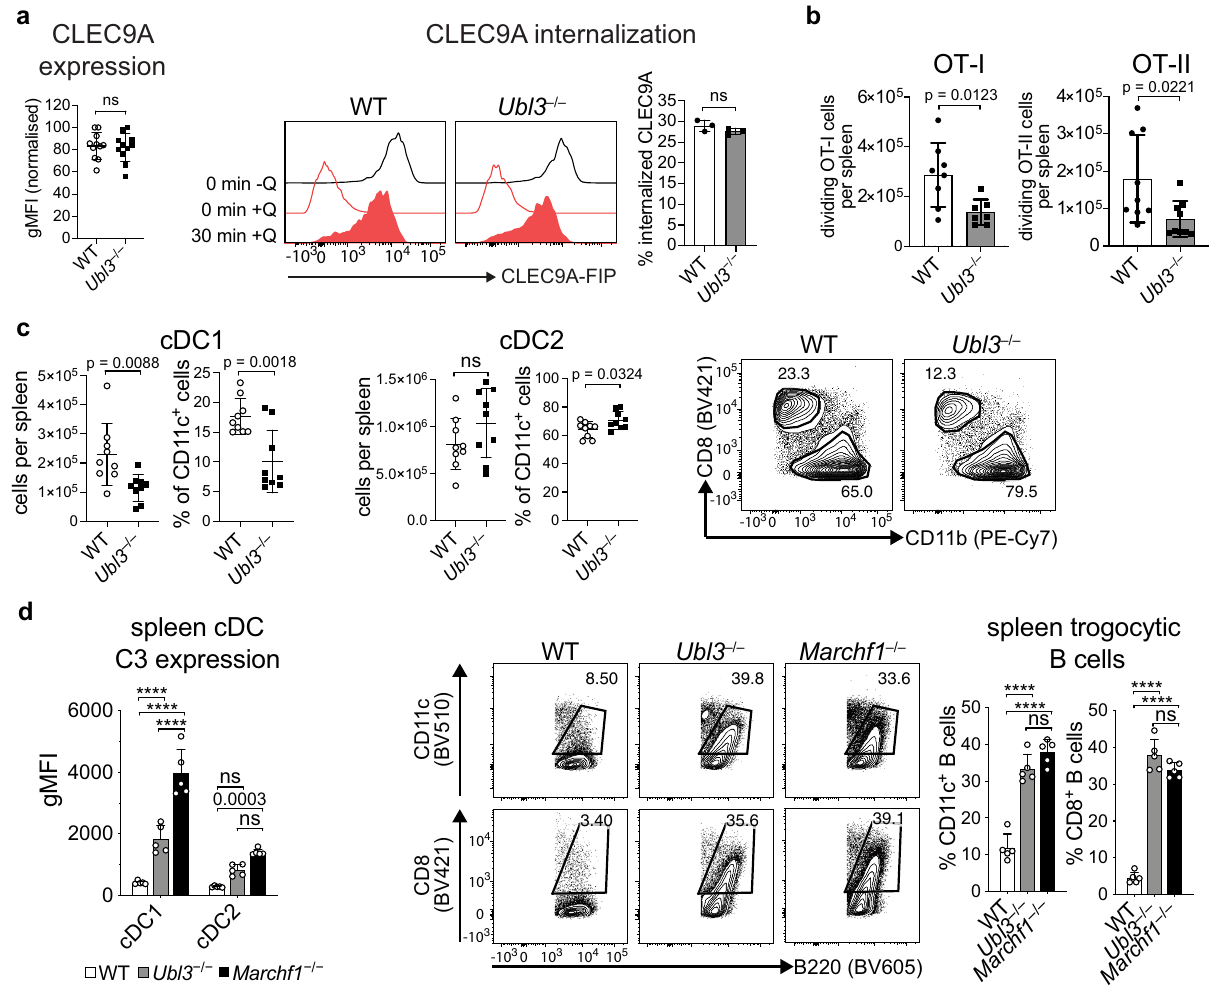
Fig. 6 Lack of UBL3 impairs DC-targeted antigen presentation in vivo. a Left: spleen cDC1 expression of CLEC9A from wild type (WT) or Ubl3 − / − mice by fl ow cytometry, n = 11 mice examined over three experiments, bars mean ± SD, symbols represent individual mice, ns (not signi fi cant) p > 0.05, unpaired t test (two-sided). Right: Spleen cDCs from WT or Ubl3 − / − mice were labeled with FIP-conjugated anti-CLEC9A mAb. After 30 mins at 37°C, quencher (Q) was added and percentage internalization was calculated as described in Methods. Histograms show representative CLEC9A-FIP signal. Right: quanti fi cation of internalization from one experiment performed in triplicate, with bars mean ± SD, ns (not signi fi cant) p > 0.05, unpaired t test (two- sided). b In vivo antigen presentation assay. Puri fi ed CellTrace Violet (CTV)-labeled OT-I and OT-II cells were adoptively transferred into WT and Ubl3 − /